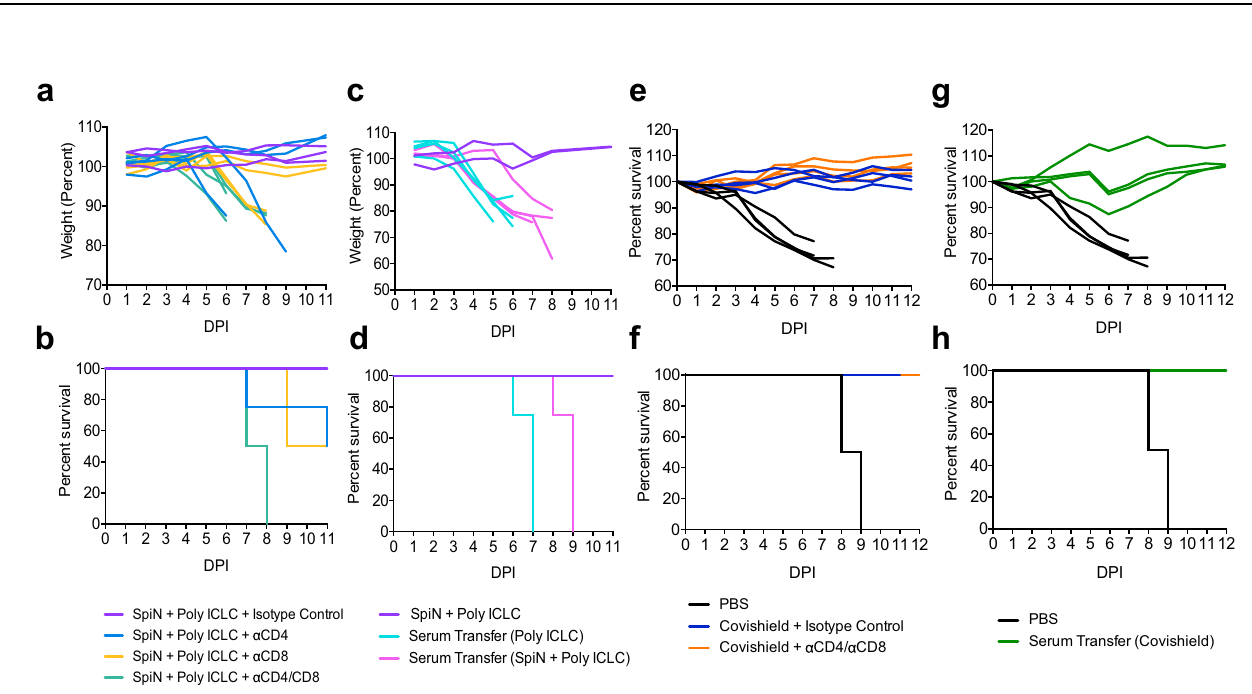
Fig.6|ProtectiveimmunityinmiceimmunizedwiththeSpiNchimericprotein andchallengedSARS-CoV-2. MicewerechallengedwiththeWuhanstrainofSARS- CoV-2. Body weight ( a ), survival ( b ) and viral load in lungs ( c ) and brain ( d ) were evaluated in K18-hACE-2 mice immunized with SpiN plus Poly ICLC and controls that received Poly ICLC alone. e Titers of nAbs in the sera from control and immunized mice at 5 dpi. Convalescent patients were used as positive control. c – e Data are presented asmean±SEM. f Histopathological analysis at2,5x, 5x, and 20xmagni fi cationofthelungsfromPolyICLCorSpiN+ PolyICLCgroups,at5dpi. Black arrows: congestion; white arrows: intra-alveolar exudate; white star: hemor- rhagic foci; asterisks: alveolar collapse; red arrows: in fl ammatory in fi ltrate. g , h mRNA expression of cytokines ( g ) and chemokines ( h ) quanti fi ed by qRT-PCR inmicelungsat5dpi. i – o ,Frequencyofmyeloid( i )andlymphoid( j )aswellastotal numbers of neutrophils ( k ), monocytes ( l ), monocyte derived dendritic cells ( m ),